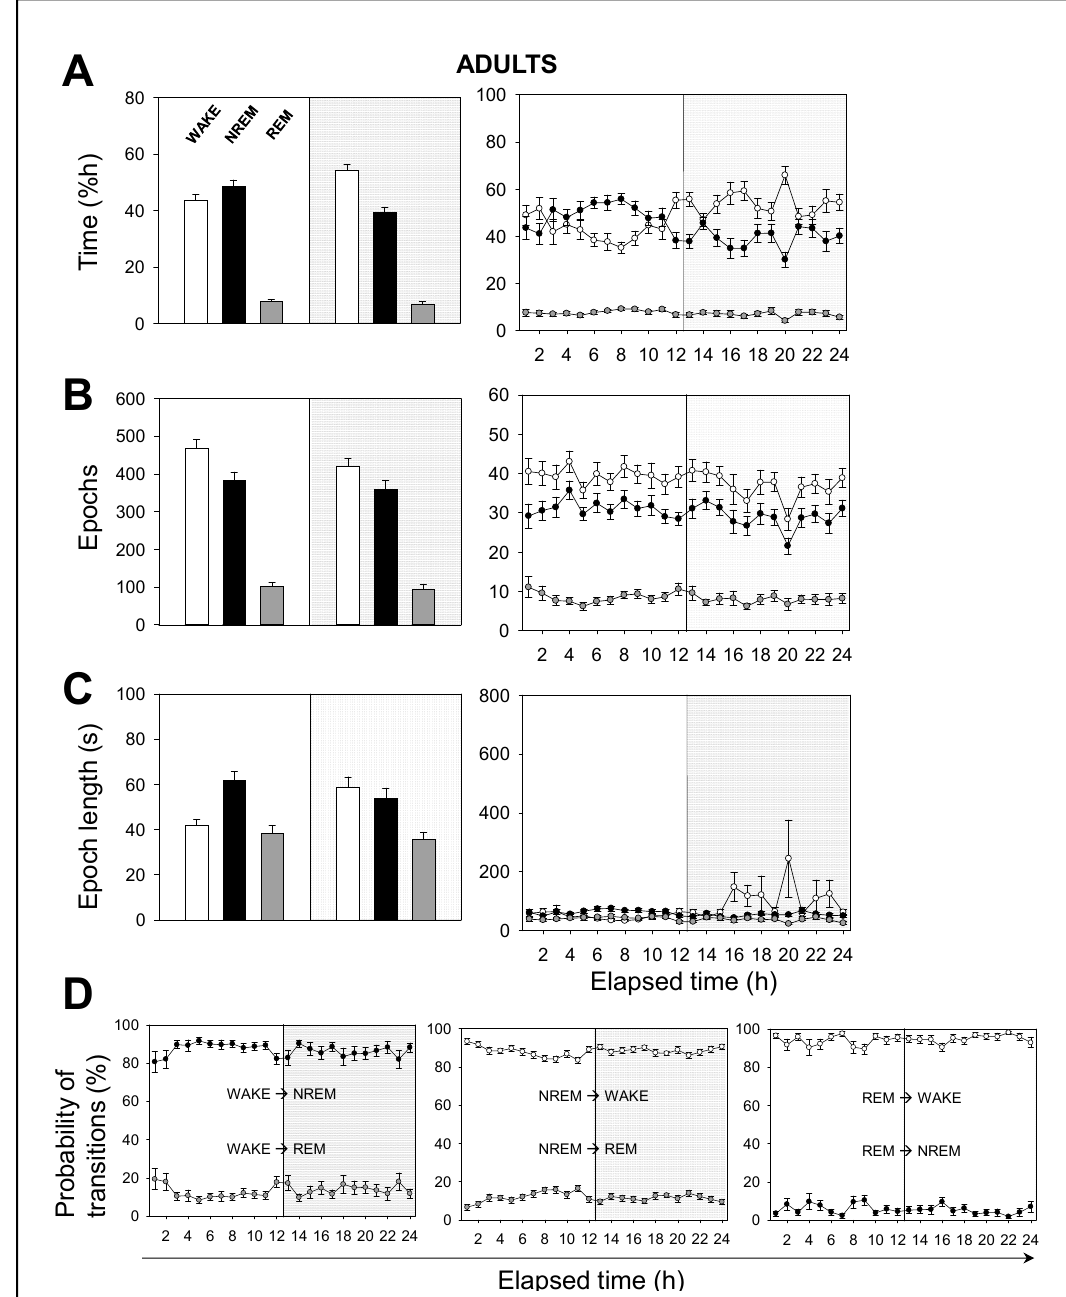
Figure 3. Sleep–wake characterization in adult mice. ( A ) Percentage of time spent, ( B ) total number of epochs, and ( C ) epoch length. White, black, and gray bars represent wakefulness, NREM, and REM sleep states, respectively. Parameters in A, B, and C are calculated during a total of 12 h-light (white background) or 12 h-dark (gray background) phases (left panels) or across the recording time within the 24 h period (right panels). ( D ) Probability of behavioral state transitions for every hour during the recording session (1–24 h). Left panel: From wakefulness into NREM and REM sleep. Middle panel: From NREM sleep into wakefulness and REM sleep. Right panel: from REM sleep into wakefulness and NREM sleep. White, black, and gray circles represent wakefulness, NREM, and REM sleep states, respectively. Data shown as mean ± SEM of 27 recordings retrieved from 11 adult